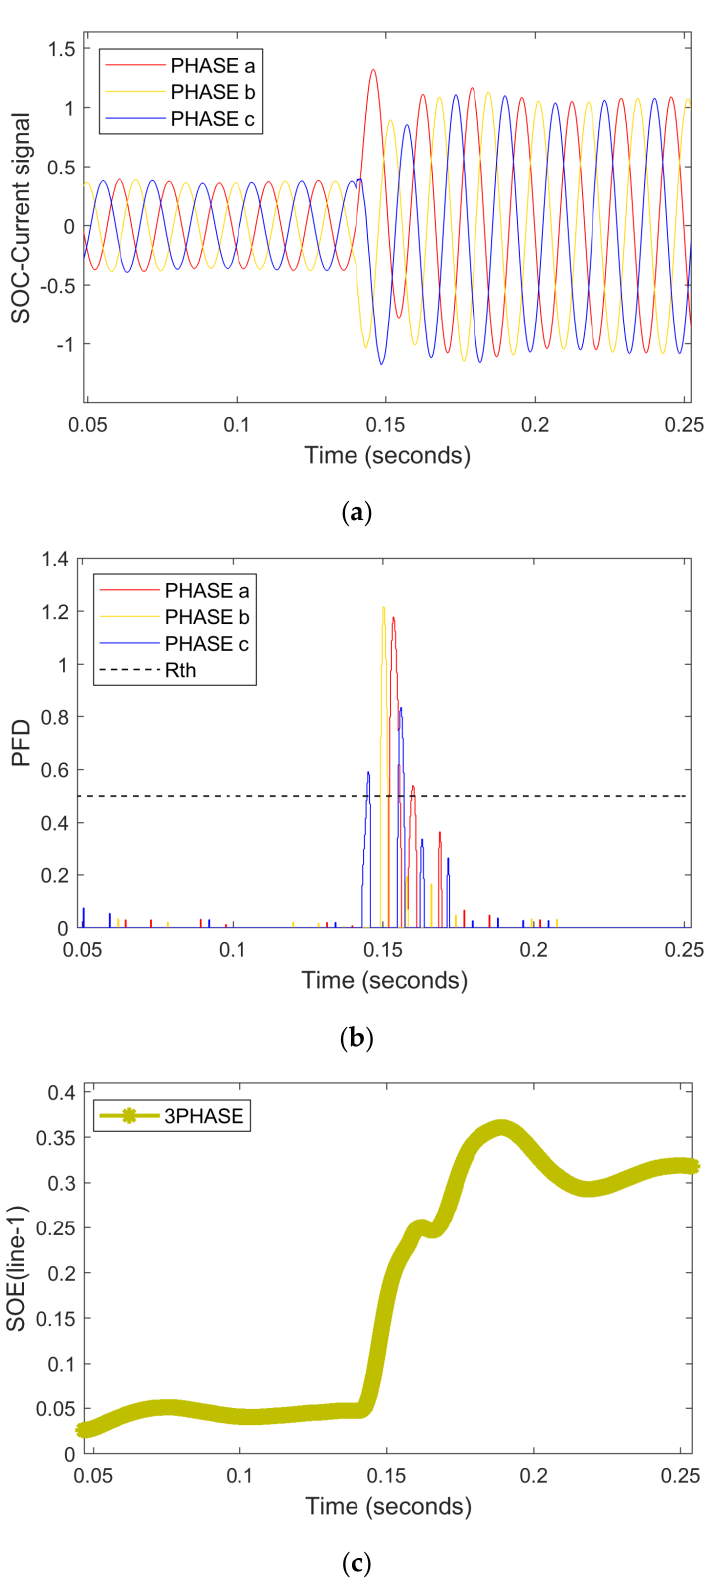
Figure 8. An LI three-phase fault with Z L = 0.1 Ω in IN mode. ( a ) Current signals ( b ) PFD ( c ) RNN- assisted SOE.